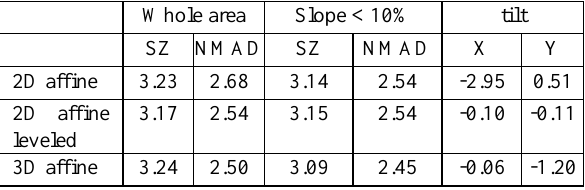
Table 9. Comparison of Cartosat-1 DSM with reference DSM in